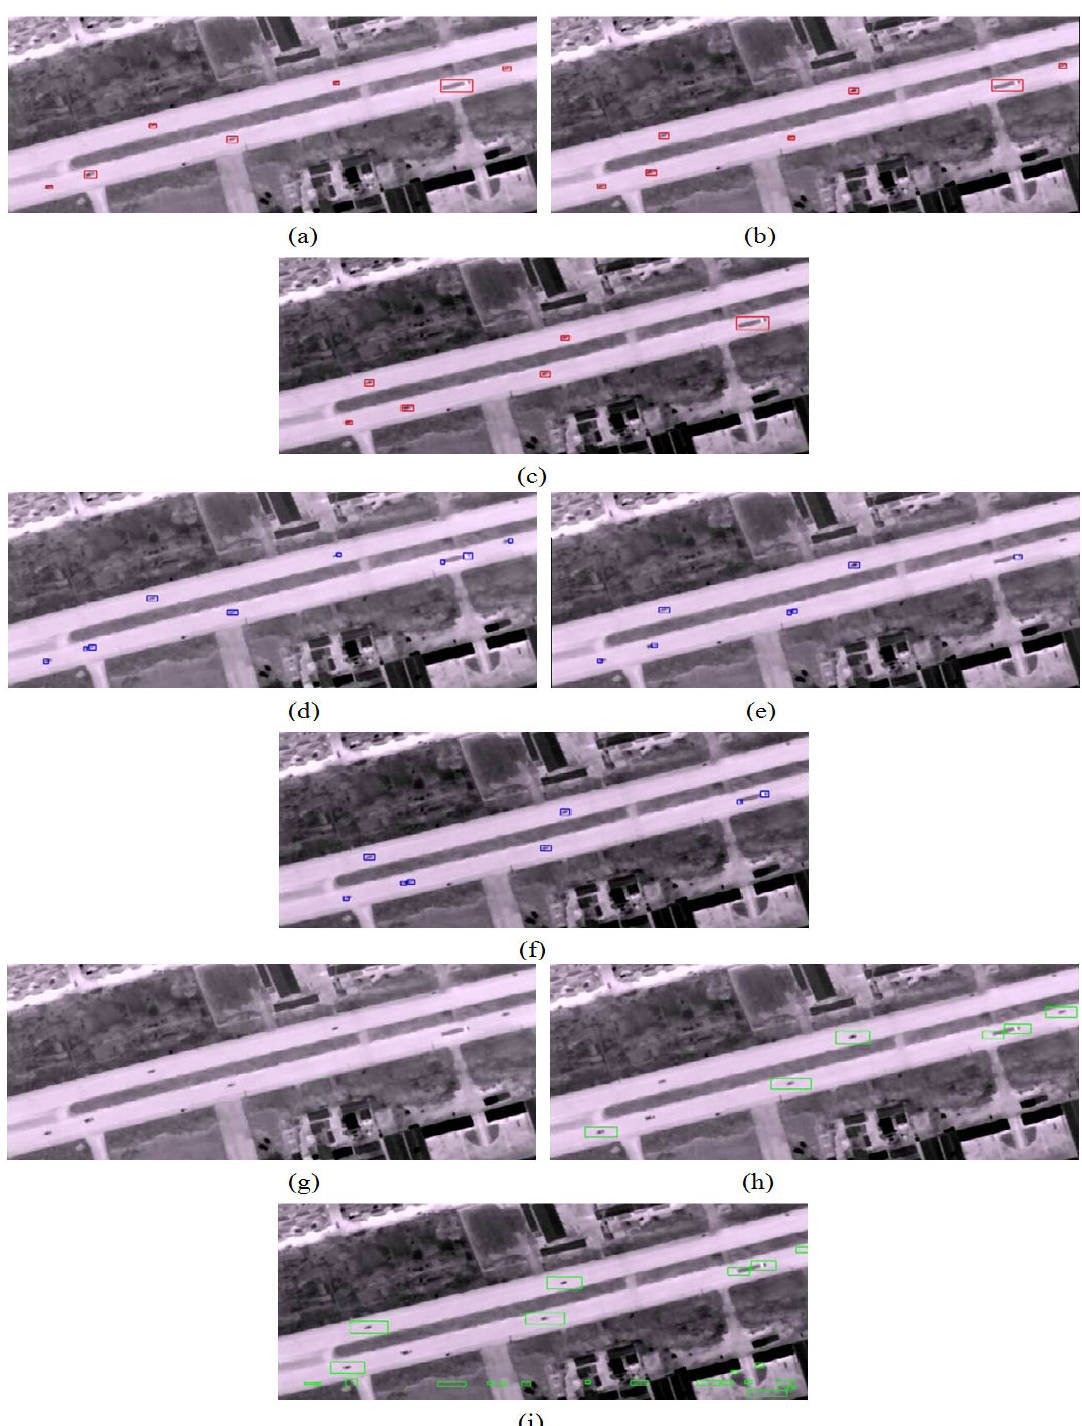
Figure 6. Target detection results for Sequence B. The area range for the detectable targets was set from 20 pixels to 800 pixels. Red rectangles are used in parts ( a – c ) respectively to represent the results obtained using SFDLC for the 10th, 55th and 100th frames; blue rectangles are used in parts ( d – f ) to represent the corresponding results obtained using SFD; and green rectangles are used in parts ( g – i ) to represent the corresponding results obtained using AFD.